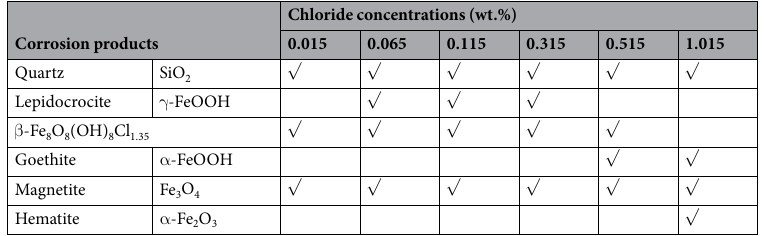
Table 4. Main compositions of corrosion products of carbon steel coupons exposed to soils of different chloride concentrations after 12